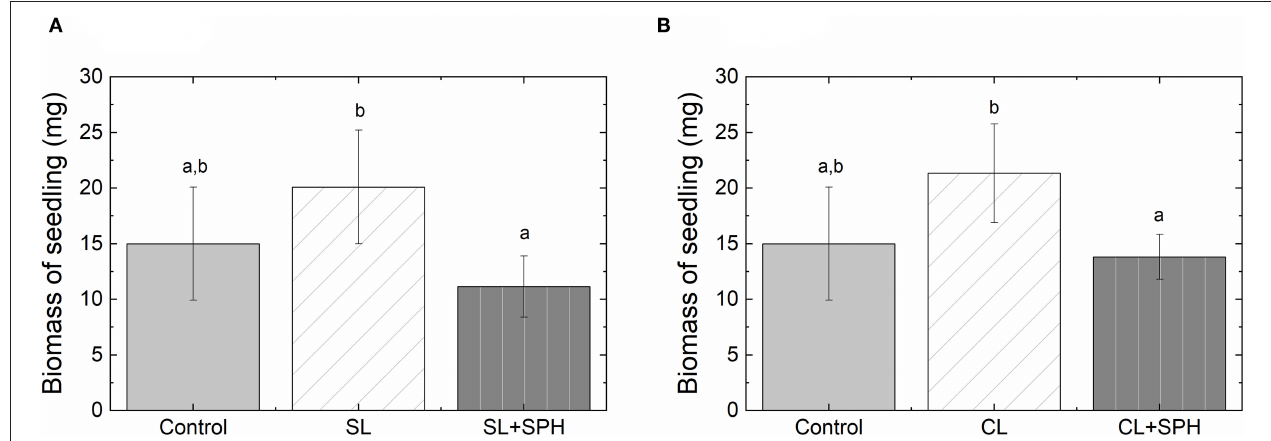
FIGURE 5 | Comparison of dried lettuce ( Lactuca sativa ) biomass in different soil types: (A) sandy loam, SL and (B) sandy clay loam, CL with (2% dw) and without spent hulls after 14 days. The control soil: Coir-Lite Mix, 0.75 yd 3 Coir, 0.25 yd 3 Perlite, no SPH. Different letters indicate significant differences in a one-way ANOVA